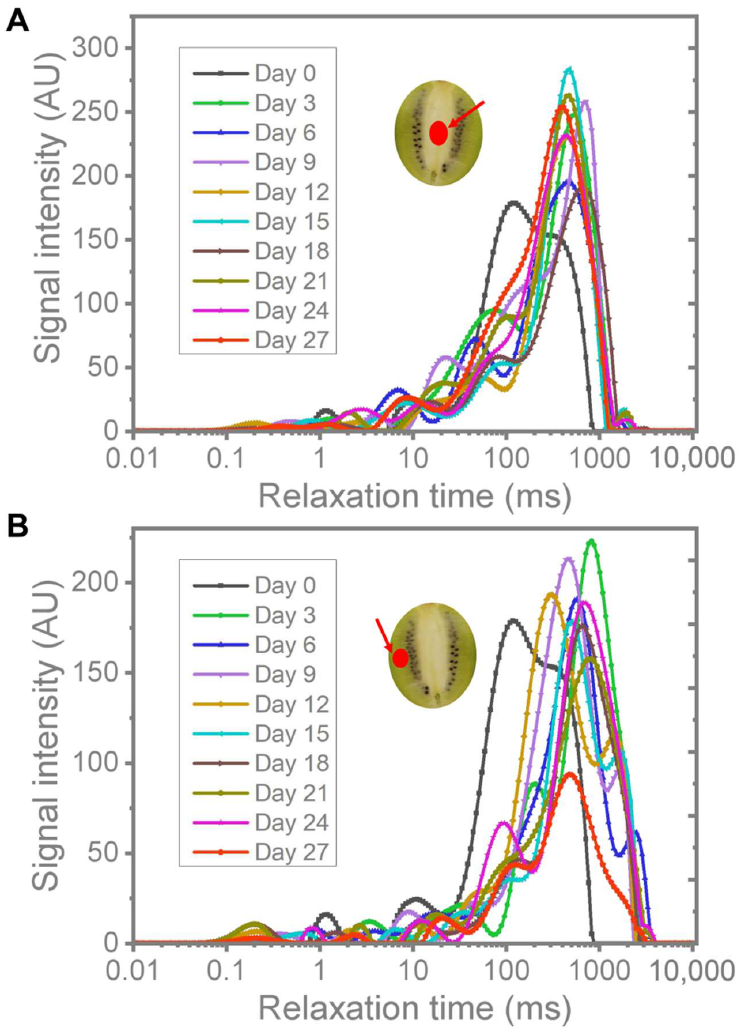
Figure 3. Moisture distribution of kiwifruit in the central part ( A ) and the mesocarp ( B ) during cold storage.